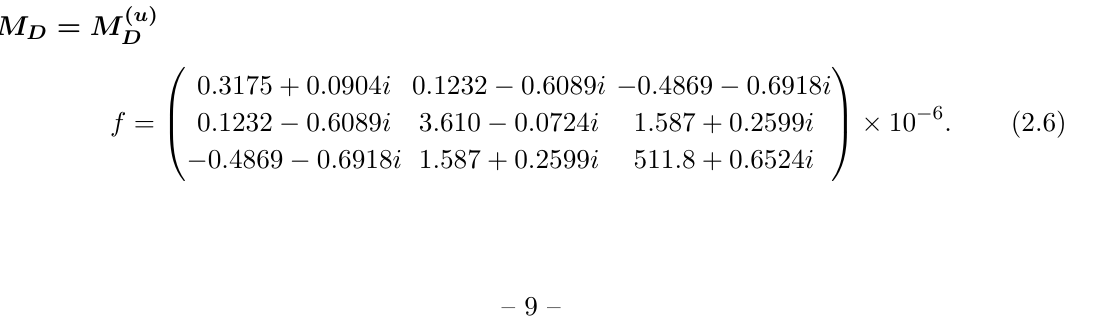
Figure 1 . Prediction of heavy RH neutrino masses as a function of the lightest neutrino mass and the quartic coupling (cid:21) in the case when the three neutrino masses are normally ordered. The top row represents a hierarchical spectrum solution of RH neutrinos and the bottom row represents a not so hierarchical scenario which we call as compact spectrum solution. The values of M (cid:1) and v R = 10 15 : 5 GeV have been kept (cid:12)xed. The value of the quartic coupling used here has been taken to be (cid:21) = 0 : 1(0 : 001) for the left panel (right